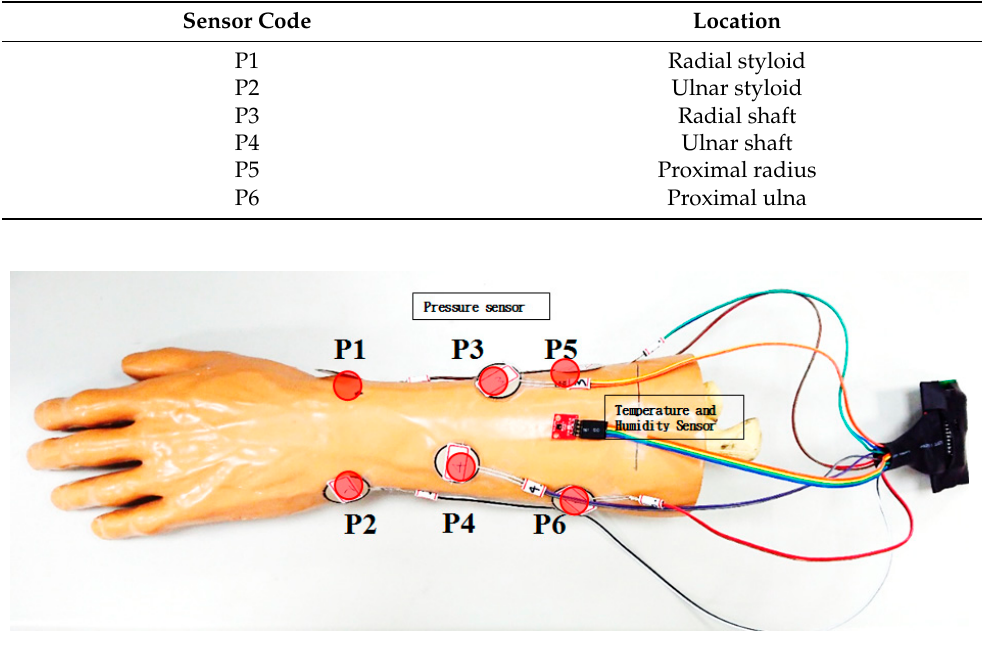
Figure 3. Location map of pressure, temperature, and humidity detection points of simulated arm.